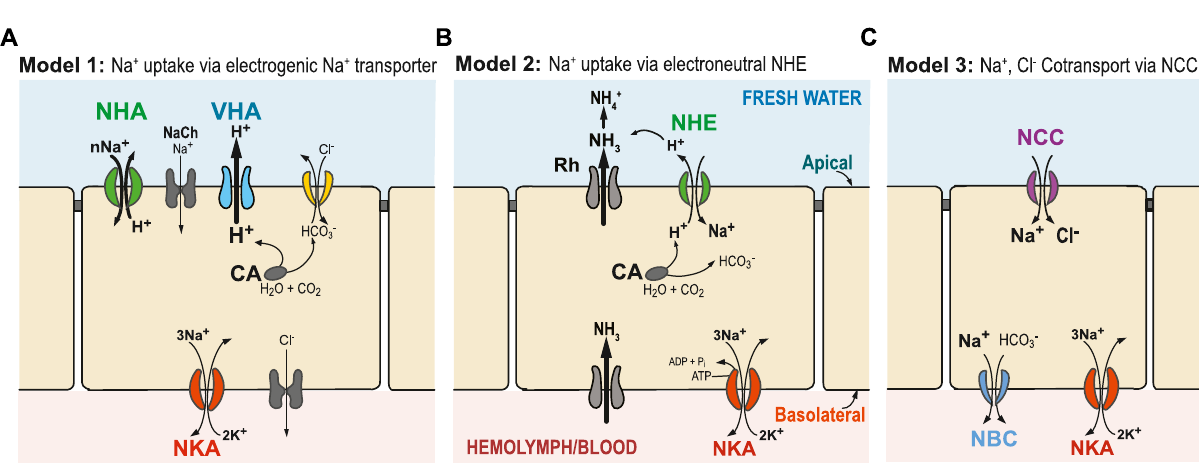
FIGURE 1 Generalized hypothetical models of ion uptake by ionocytes in aquatic animals under freshwater conditions. (A) Model 1 (Wieczorek ’ s Model): VHA (blue) pumps out H + and creates an electrical gradient, through which Na + is transported into the cell through an electrogenic Na + transporter (potentially NHA or Na + channel, NaCh). (B) Model 2: Ammonia is transported out of the cell by an ammonia transporter (Rh protein), which then drives electroneutral NHE (green) to export H + , and consequently import Na + . (C) Model 3: Na + and Cl − are co-transported to the cell by the NCCorNCC-likecotransporter.Inthesethreemodels,transportofNa + acrossthebasolateralmembranefromthecelltothehemolymphorbloodis performed by the primary transporter NKA (red) and, potentially, also by NBC (blue, in Model 3). Cytosolic carbonic anhydrase (CA) performs CO 2 hydration, supplying H + and